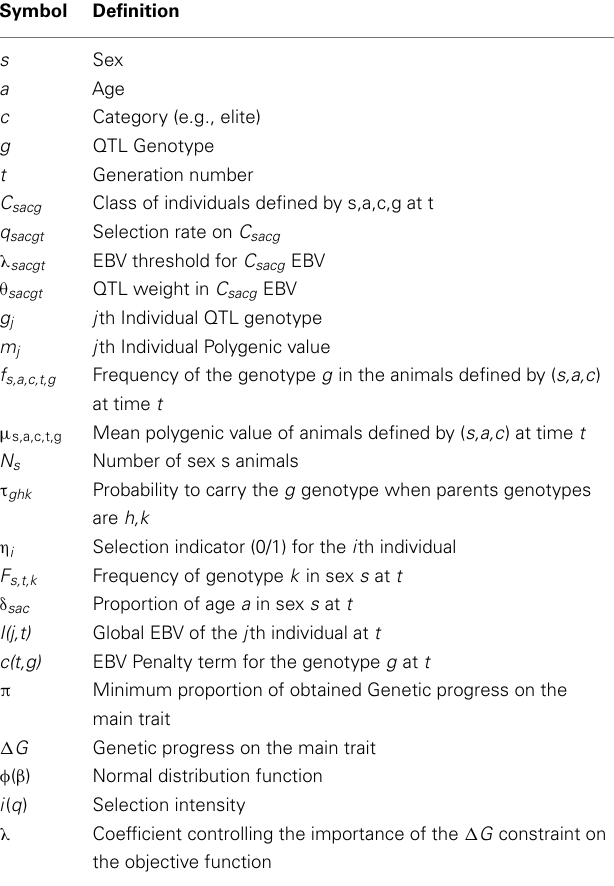
Table 1 | Definition of the model